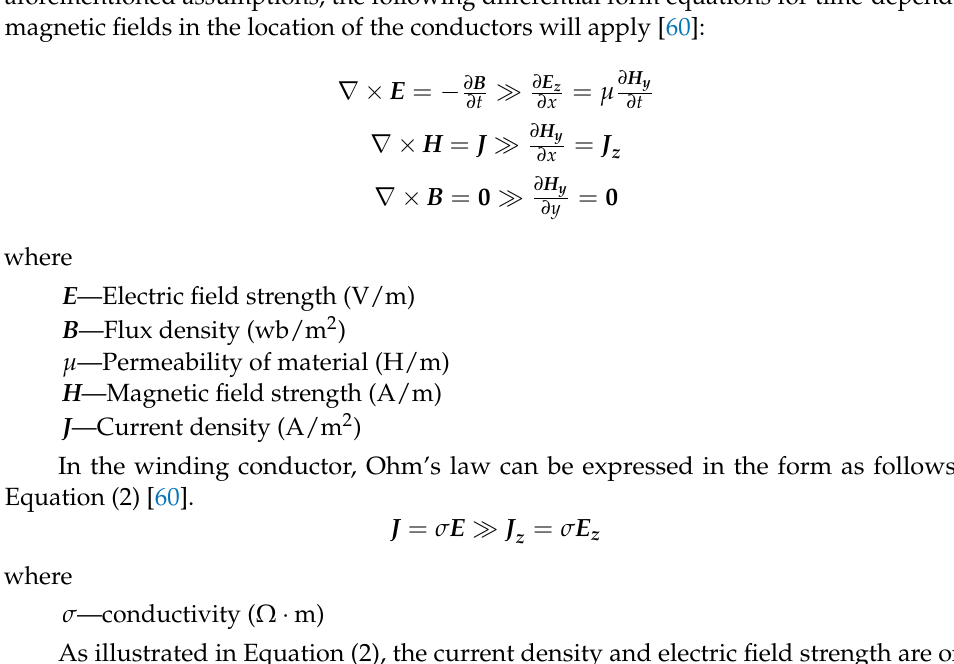
Figure 9. Reference coordinate system for loss computation.